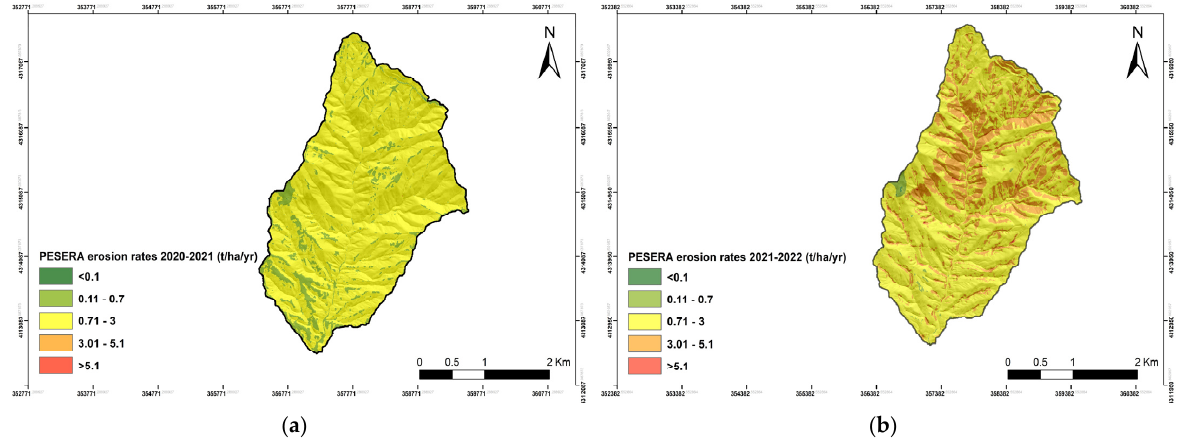
Figure 11. PESERA erosion rates (t ha − 1 ) ( a ) from September 2020 to August 2021, ( b ) from October 2021 to September 2022. 2021 to September 2022.